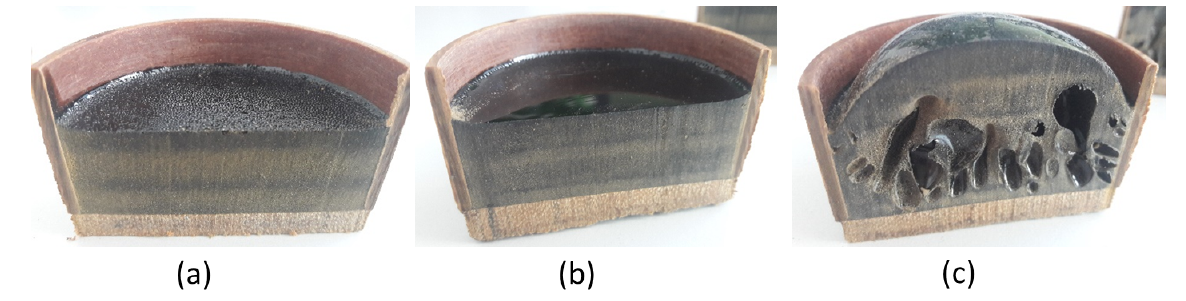
Figure 7. Sectional view of different compositions of HTPB, IPDI and DBTL. All mixtures were performed with the same new type of HTPB and constant amount of carbon black: ( a ) mixture with 7.66% IPDI; ( b ) mixture with 9.58% IPDI; ( c ) mixture with 11.50% IPDI. Pictures: F. Heeg, IRAS, TU Braunschweig.